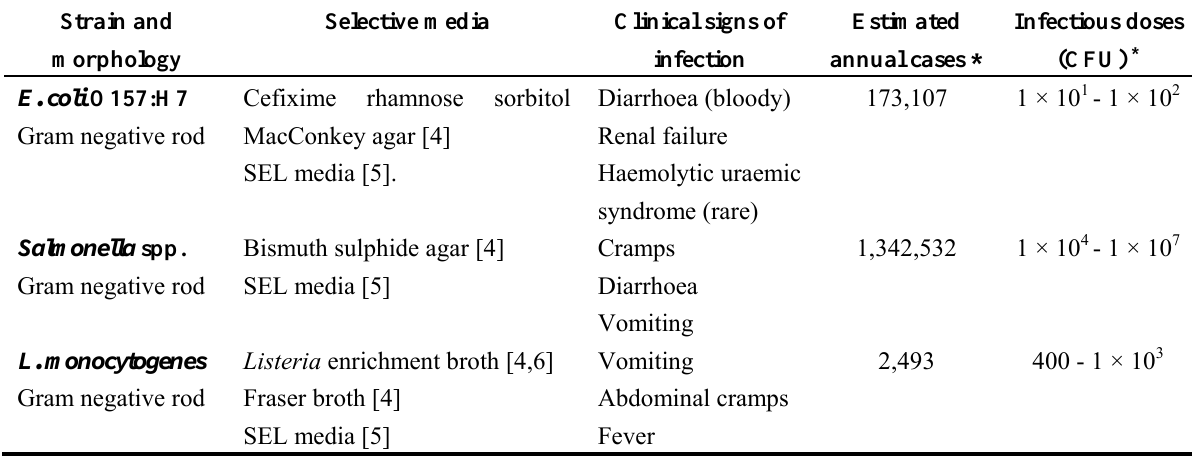
service. Key: CFU - colony-forming